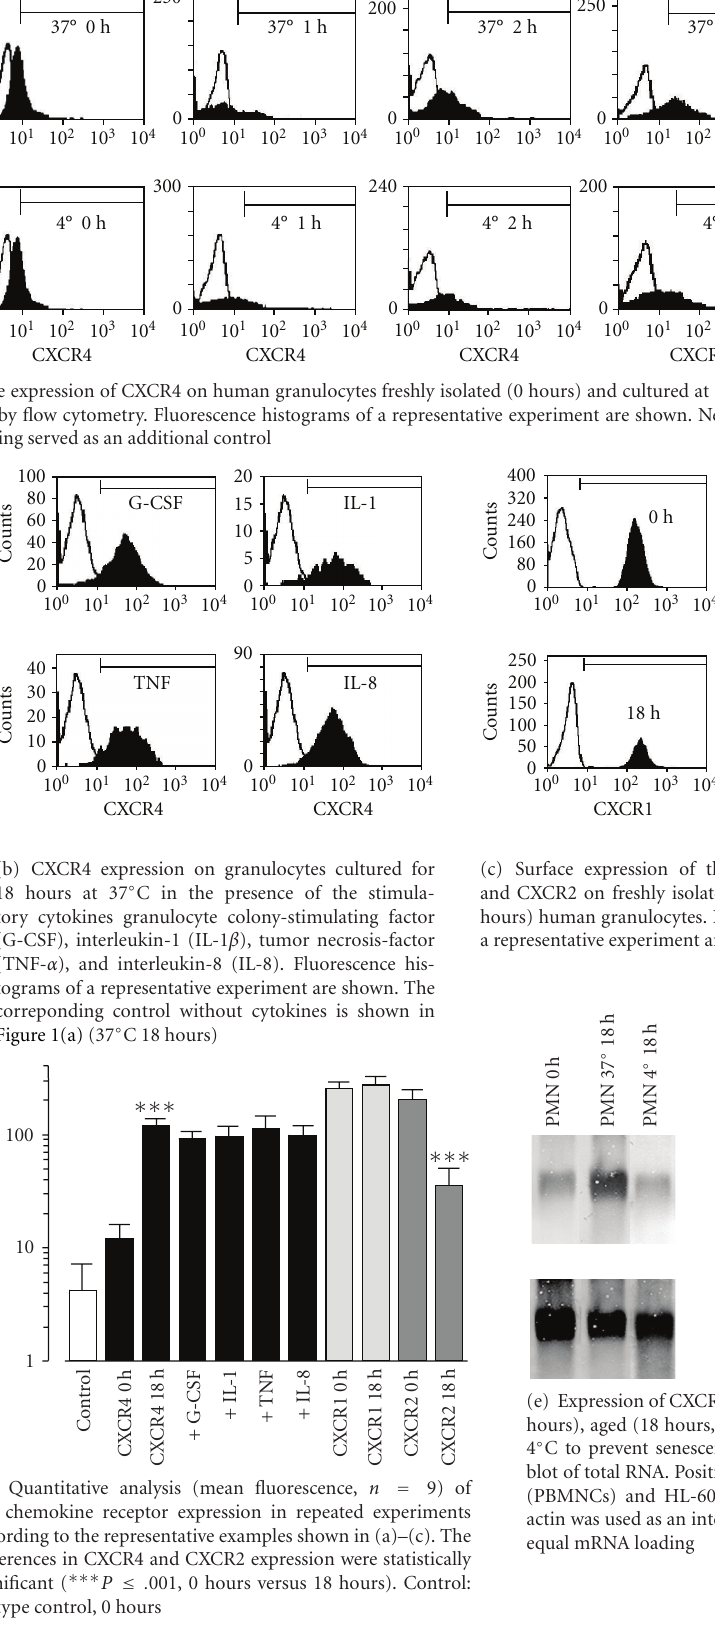
Figure 1: Expression of CXCR4, CXCR1, and CXCR2 in human granulocytes during aging in